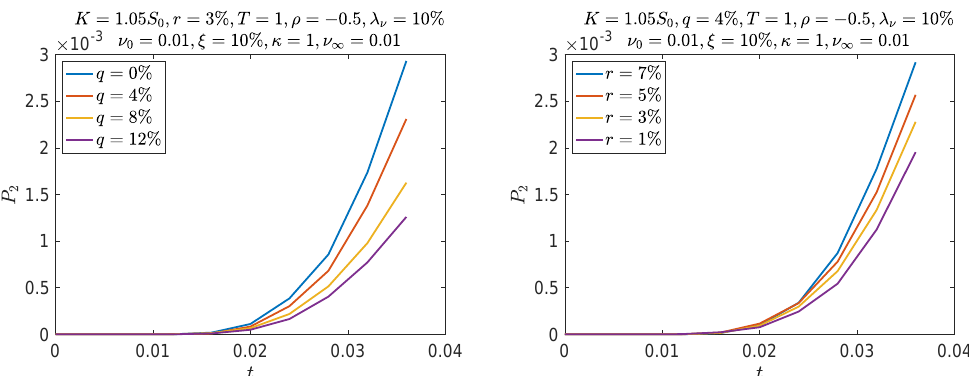
Figure 6. Probability that a call option on S in within the Heston model is in the money at the first eight monitoring dates. Daily monitoring (250 dates for a T = 1 year maturity). Table 5. Numerical results, Heston model. S 0 = 100, T = 1, ν 0 = 0.01, ξ = 10%, κ = 1, ν ∞ = 0.01, ( 0 ) : initial price of the European call λ ν = 10%; 150 possible exercise dates per year. π E H